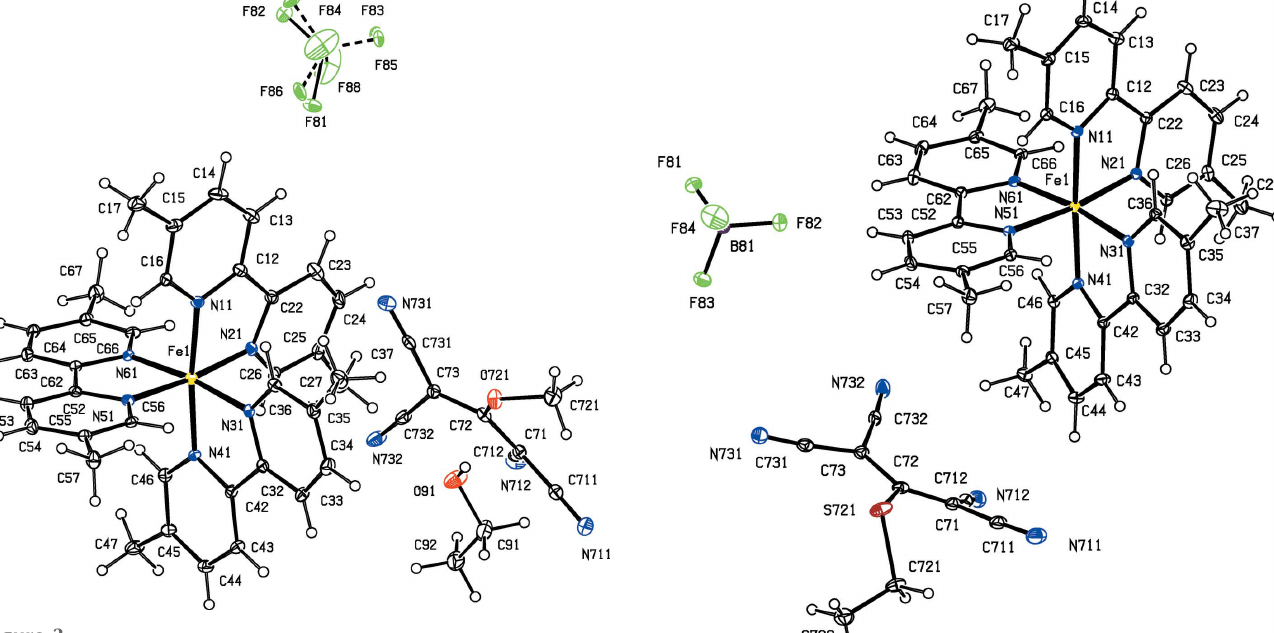
Figure 3 The independent ionic components in compound (III), showing the atom- labelling scheme. Displacement ellipsoids are drawn at the 30% probability